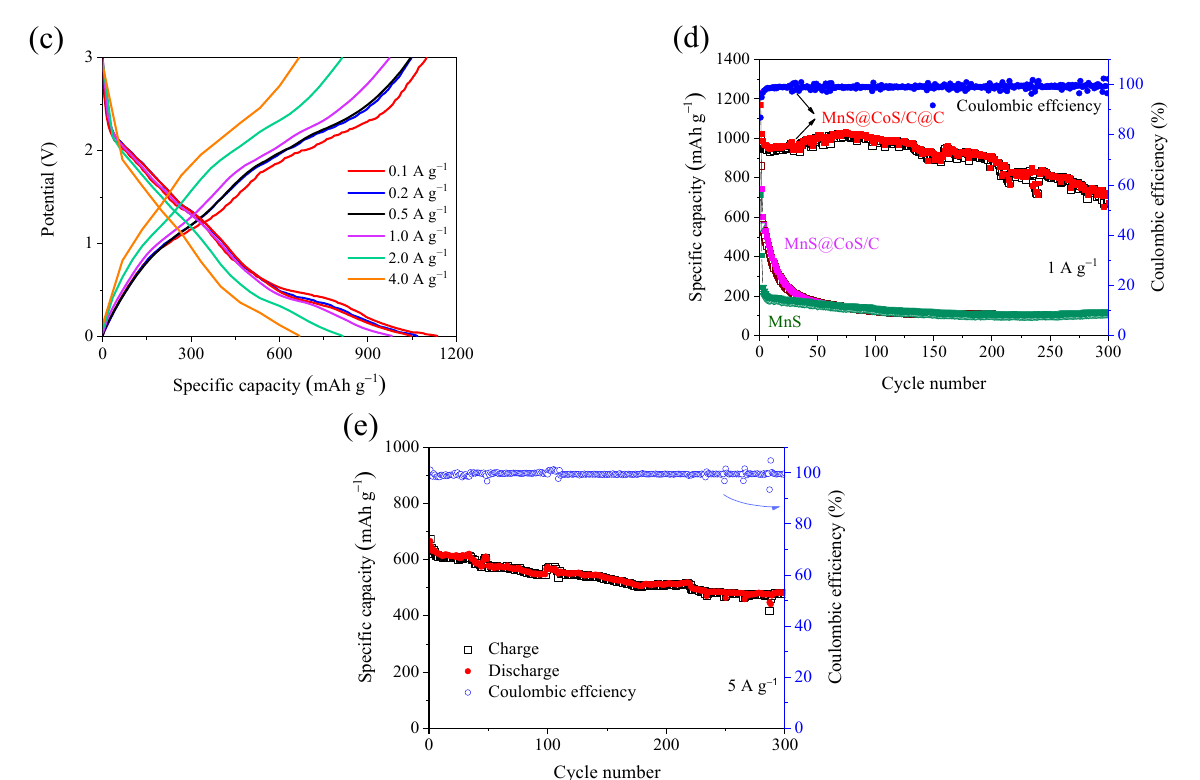
Figure 6. ( a ) Rate performance of MnS@CoS/C@C and MnS@CoS/C, ( b ) Comparison of rate capability of MnS@CoS/C@C and α -MnS [21], MnS@C-800 [25], MnS/RGO [34], CoS/CNTs [40], CoS NFs-rGO [41], γ -MnS [42], MnS@C [43], γ -MnS/rGO [44], CoS 2 [45], CoS 2 NP@G-CoS 2 QD [46],